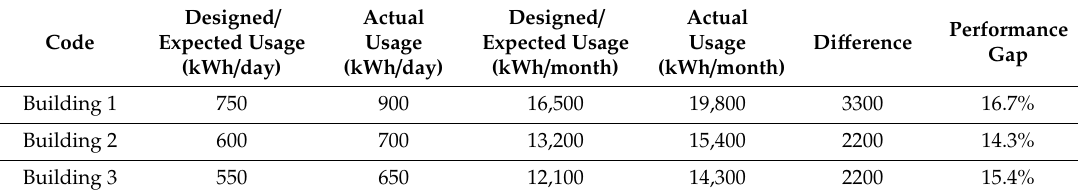
Table 4. The performance gap between predicted and actual energy